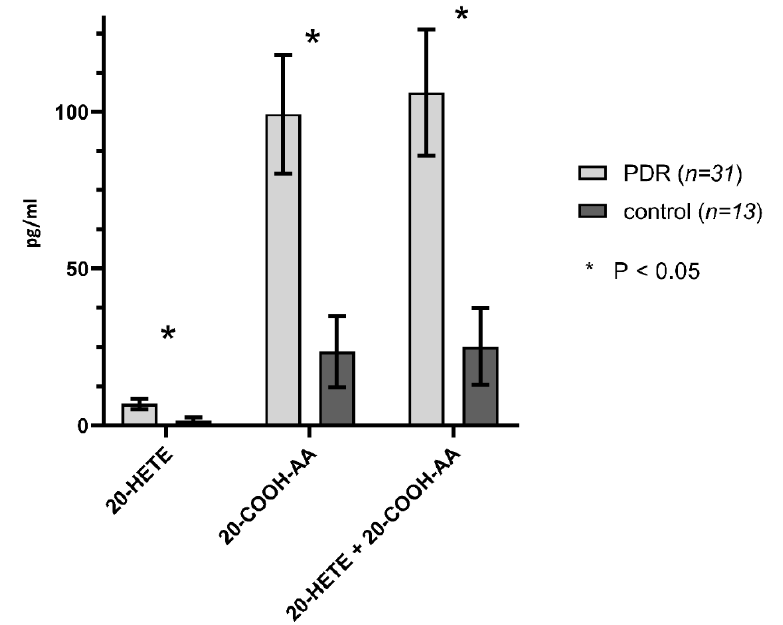
Figure 4. Human vitreous levels of eicosanoids in PDR ( n = 31) vs. control ( n = 13) eyes. Comparison of levels (pg/mL) of 20-HETE, 20-COOH-AA in PDR vs. controls. * denotes statistical significance ( p < 0.05).